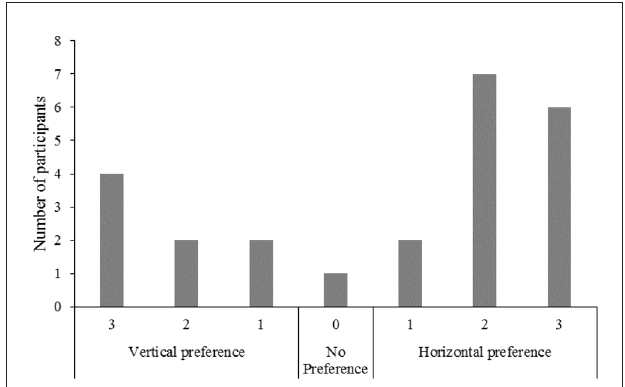
FIGURE 3 | Frequency of responses for the question “On which screen did you prefer watching the ball pinch?”.